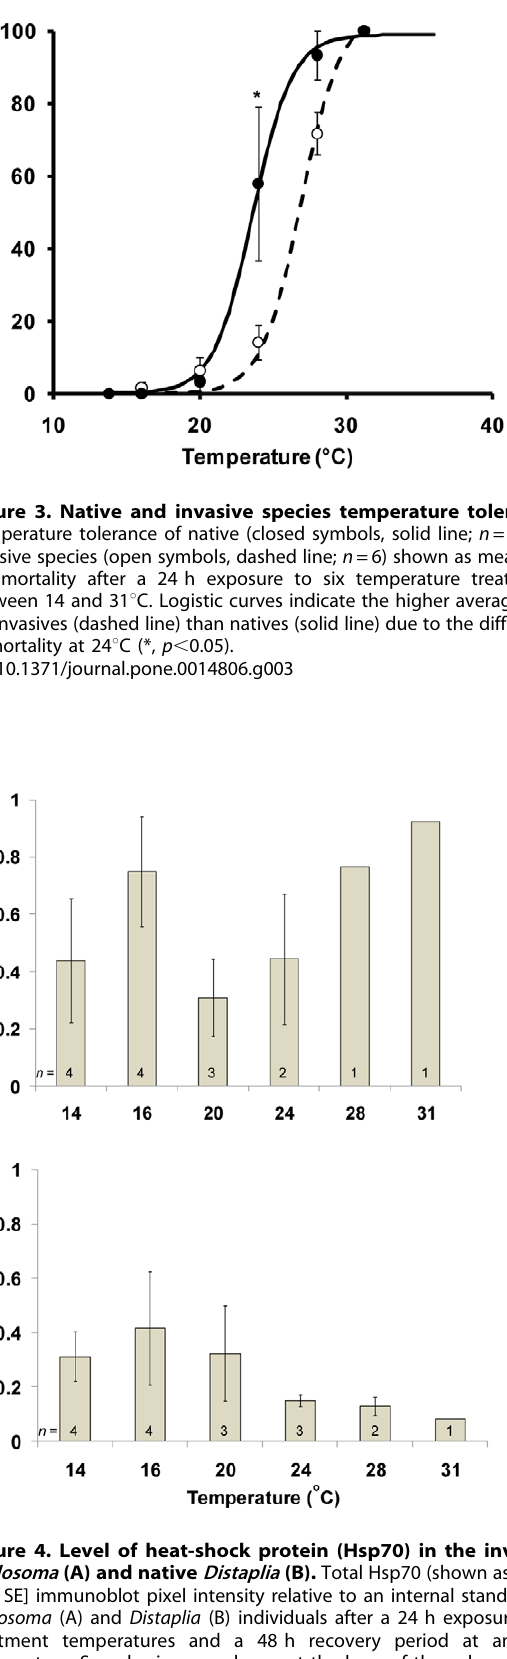
PLoS ONE | www.plosone.org 3 April 2011 | Volume 6 | Issue 4 |